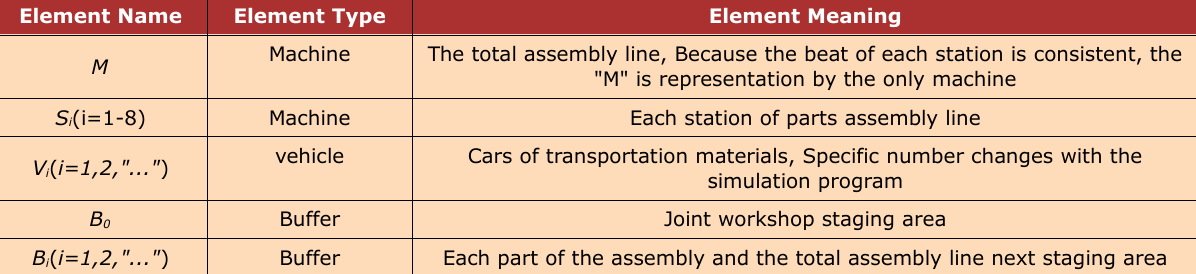
Table 2. The definition of the main entity elements in the simulation